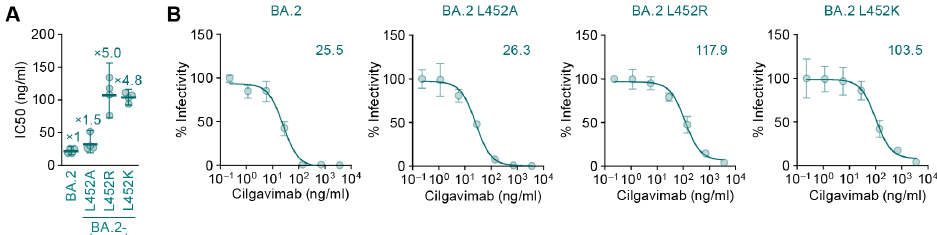
Figure 2. Neutralization sensitivity of the SARS-CoV-2 Omicron BA.2-based mutants to cilgavimab. ( A ) Pseudovirus neutralization assay. Assays were performed using pseudoviruses harboring the SARS-CoV-2 spike proteins of Omicron BA.2 and its derivatives (the BA.2 spike bearing L452A, L452R, or L452K, respectively). The assay was performed in triplicate at each concentration of cilgavimab to determine the IC50 value (ng/mL), and the assay was independently performed four times. Each dot represents one IC50 value, and the mean and 95% confidential interval is shown. The numbers indicate the fold changes of resistance versus BA.2. ( B ) Representative neutralization curves of the assay are shown. The numbers in the panels indicate the IC50 (ng/mL).